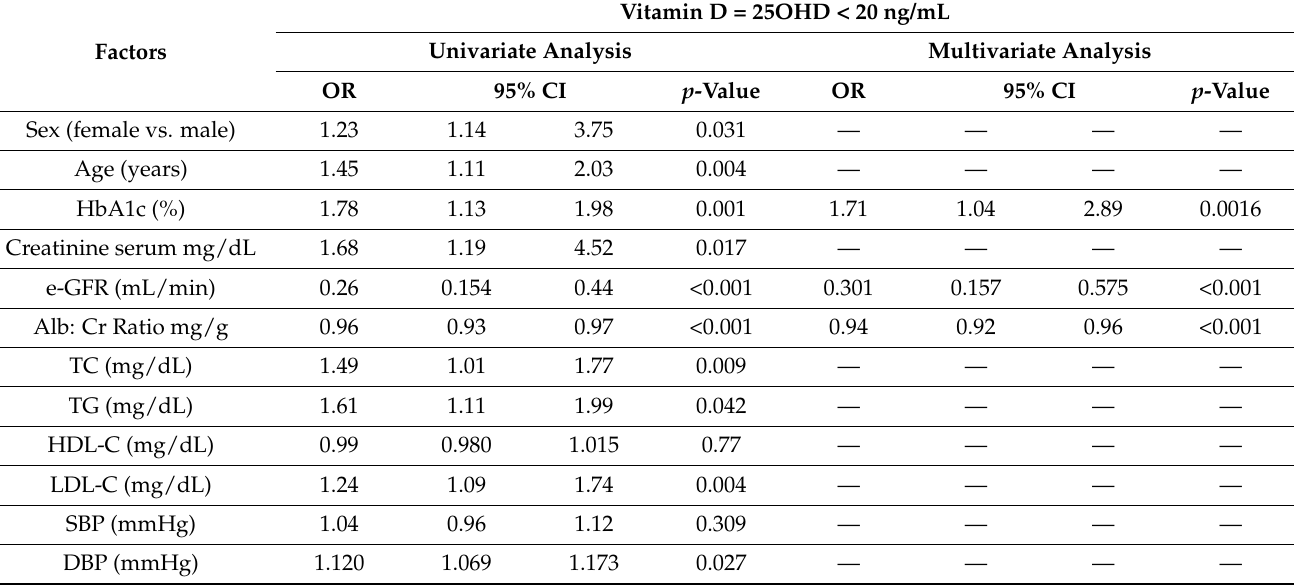
Notes: p values less than 0.05 were considered statistically significant, “—” not included in the multivariate logistic regression model Abbreviations: OR, odds ratio; CI, confidence interval; HbA1c, hemoglobin A1c; HDL- C, high-density lipoprotein cholesterol; LDL-C, low-density lipoprotein cholesterol; TC, total cholesterol; TG, triglyceride, e-GFR; glomerular filtration rate, Alb: Cr; albumin to creatinine ratio, SBP, systolic blood pressure; DBP, diastolic blood